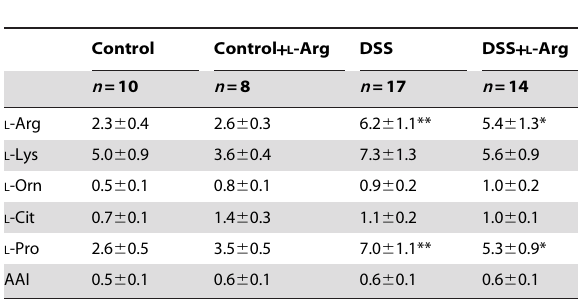
Table 2. Amino acids in the colonic tissue from DSS colitis in the presence or absence of